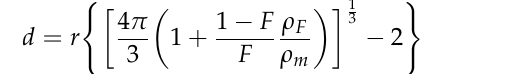
where r is the nanoparticle radius; F is the mass fraction of nanoparticles; ρ F and ρ m are the densities of nanoparticles and polymer matrices, respectively. According to the trap cross- section and trap density and nanoparticle content, the spatial coordinates of nanoparticles are randomly generated using MATLAB random function rand to build a SiO 2 /epoxy as shown in Figure 8, and the corresponding number of SiO 2 nanoparticles is shown in Table 7. Set the electrostatic field boundary conditions of the nano-dielectric model: the lower surface potential is 3.5 V, the upper surface is grounded, and the electron emission inlet is set to the upper surface. Table 7 Number and spacing of SiO 2 nanoparticles in the nano dielectric model with different filling